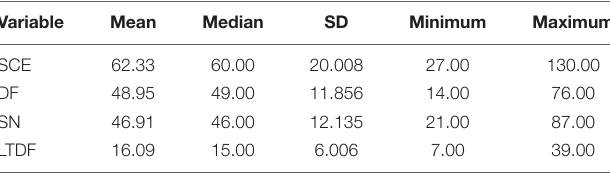
TABLE 3 | Descriptive statistics for TDEQ variables.